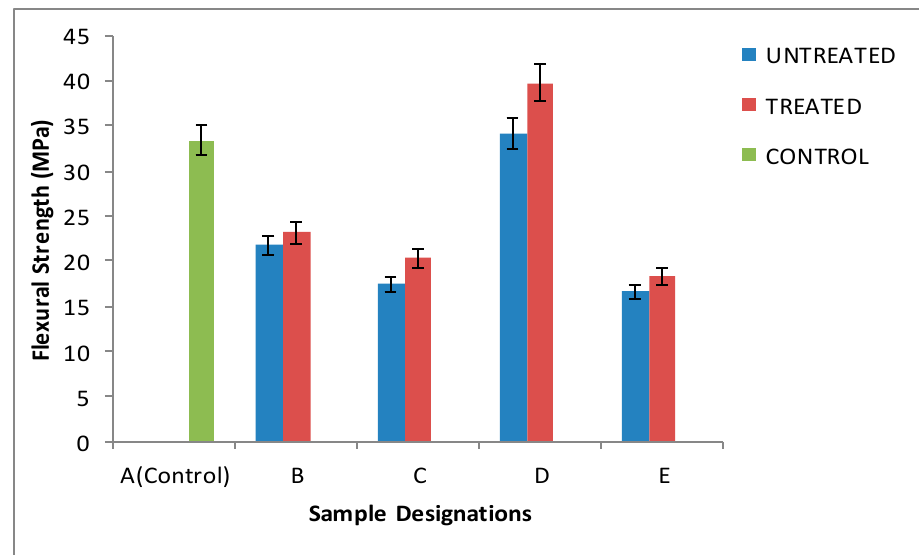
Figure 8. The flexural strength of the control sample and the developed composites.